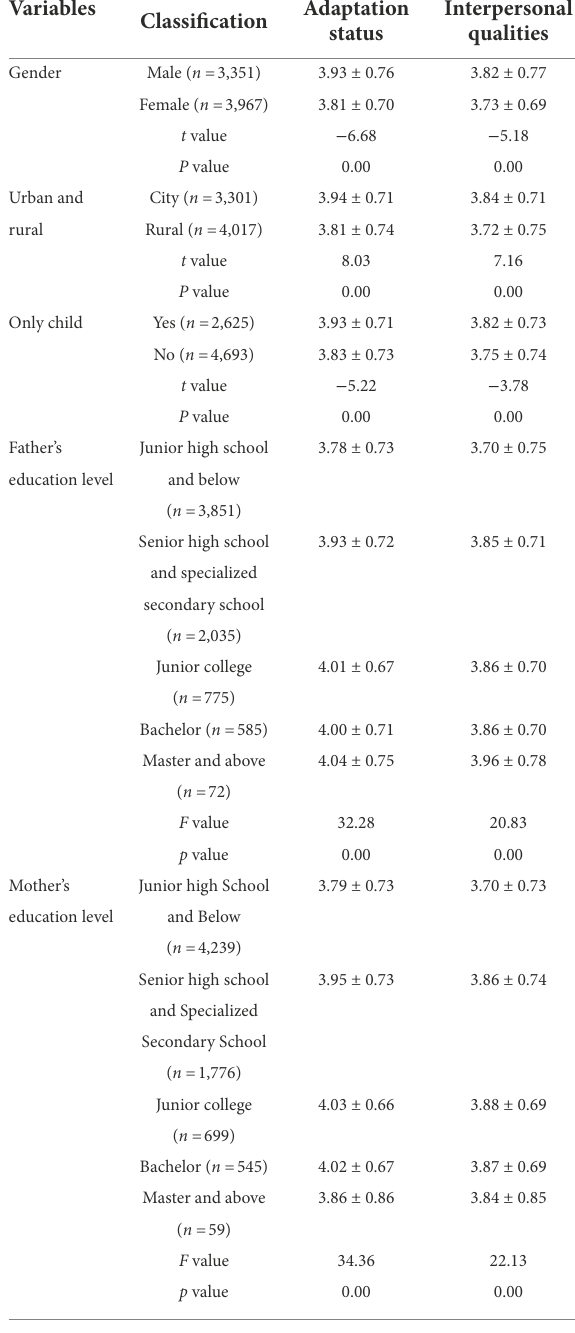
TABLE 2 Comparison in adaptation and interpersonal quality among Chinese adolescents (M ± SD). Variables